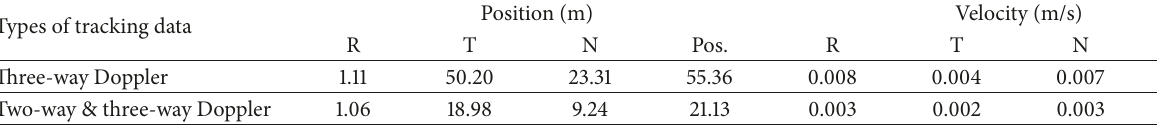
Table 3: The reconstructed orbit differences between SODP and ROB.